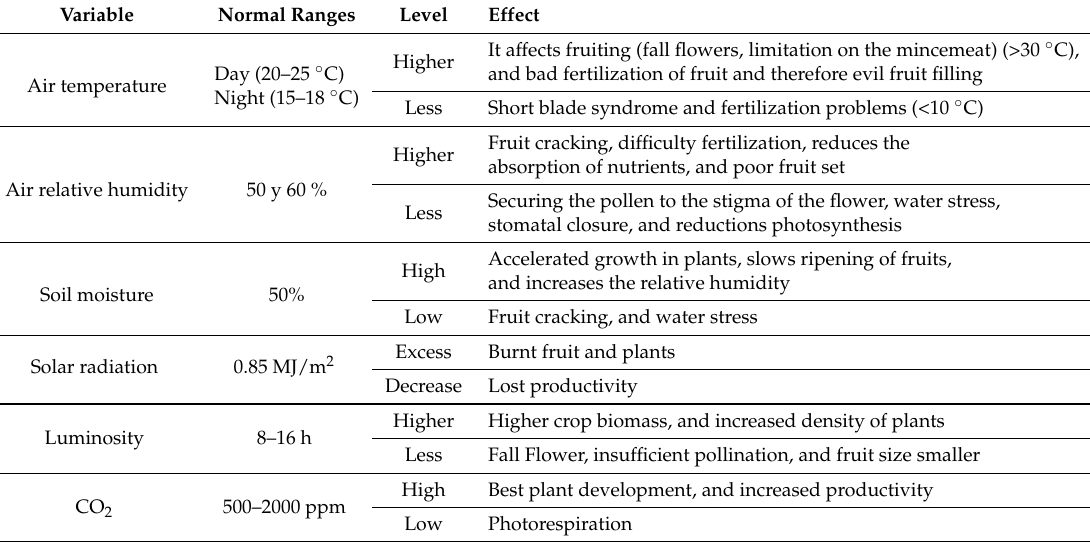
Table 2. Compilation of the required climatic conditions for growing tomatoes.